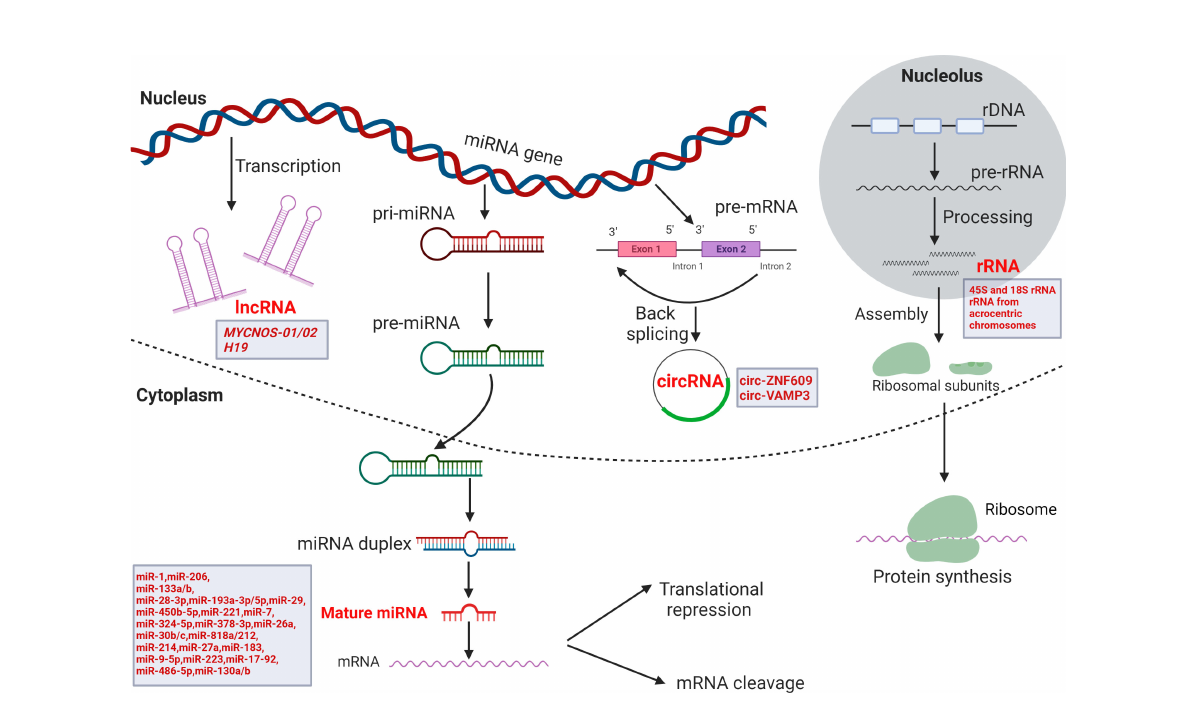
FIGURE 1 The different types of ncRNA that are implicated in RMS progression and metastasis. From left to right: lncRNA can be transcribed from different regions of DNA including enhancers and promotors; miRNA are transcribed fi rst as pri-miRNA sequences which are subsequently processed into pre-miRNA and transported into the cytoplasm to complete maturation and bind to target mRNA for silencing or degradation; a pre-mRNA can be back-spliced to form a circRNA; within the nucleolus, rDNA can encode rRNA that regulate protein synthesis within the ribosomal complex. The ncRNA implicated to date in RMS biology and progression are represented within boxes. Created